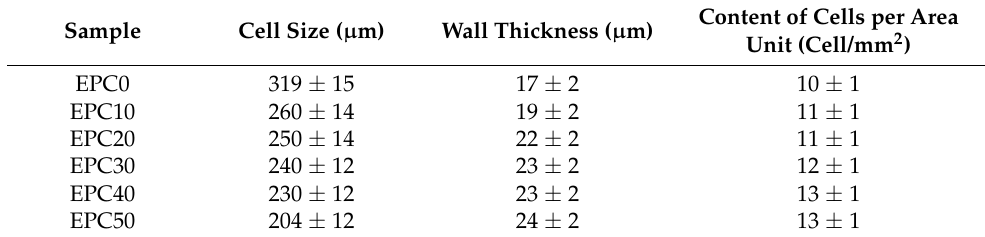
Table 2. Statistical analysis of SEM